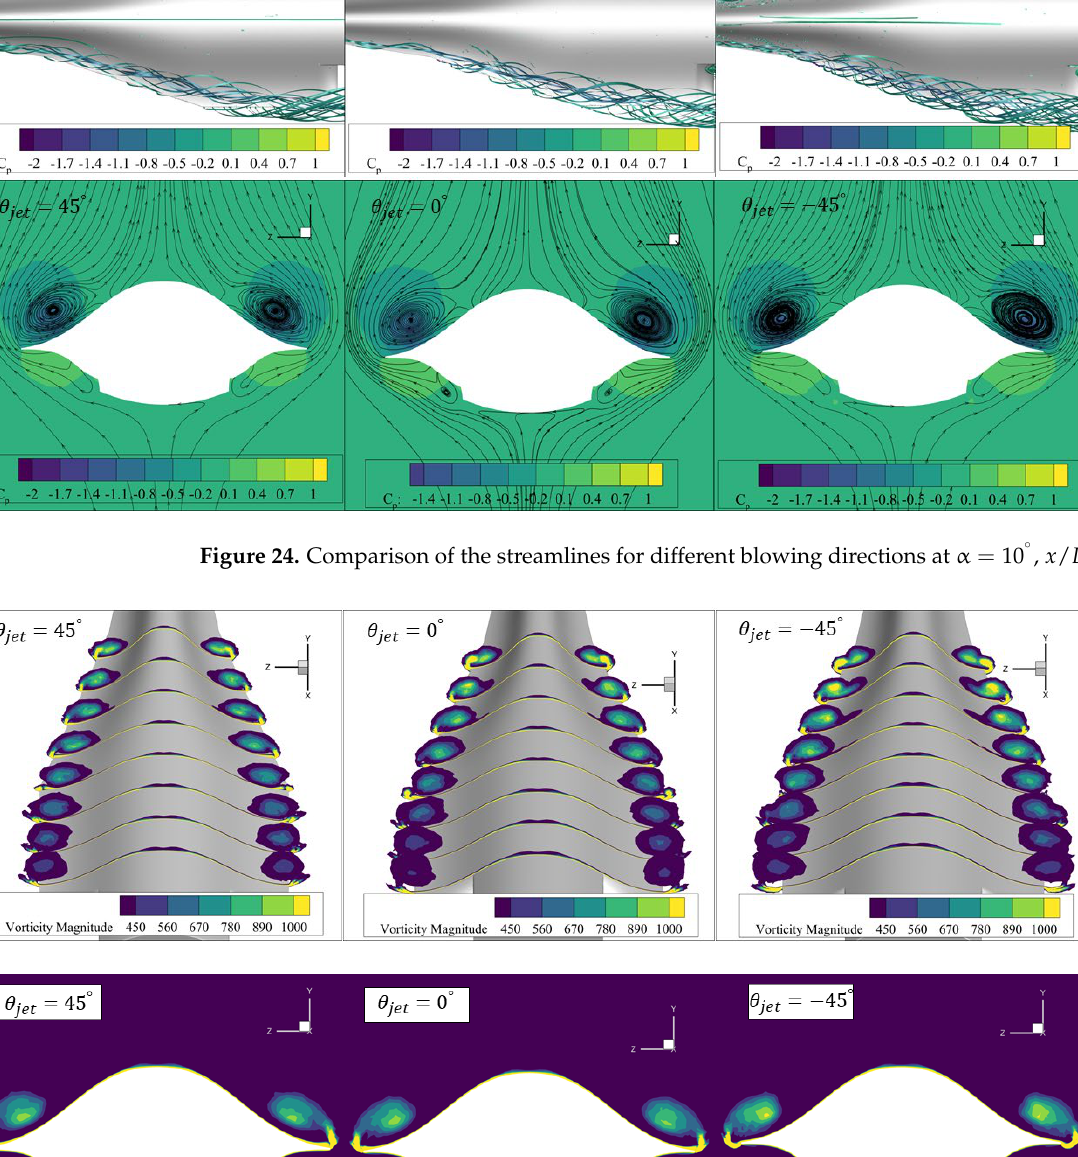
Figure 23. Comparison of the pressure coefficient distributions on the upper surfaces for different blowing directions at . ° α = 10